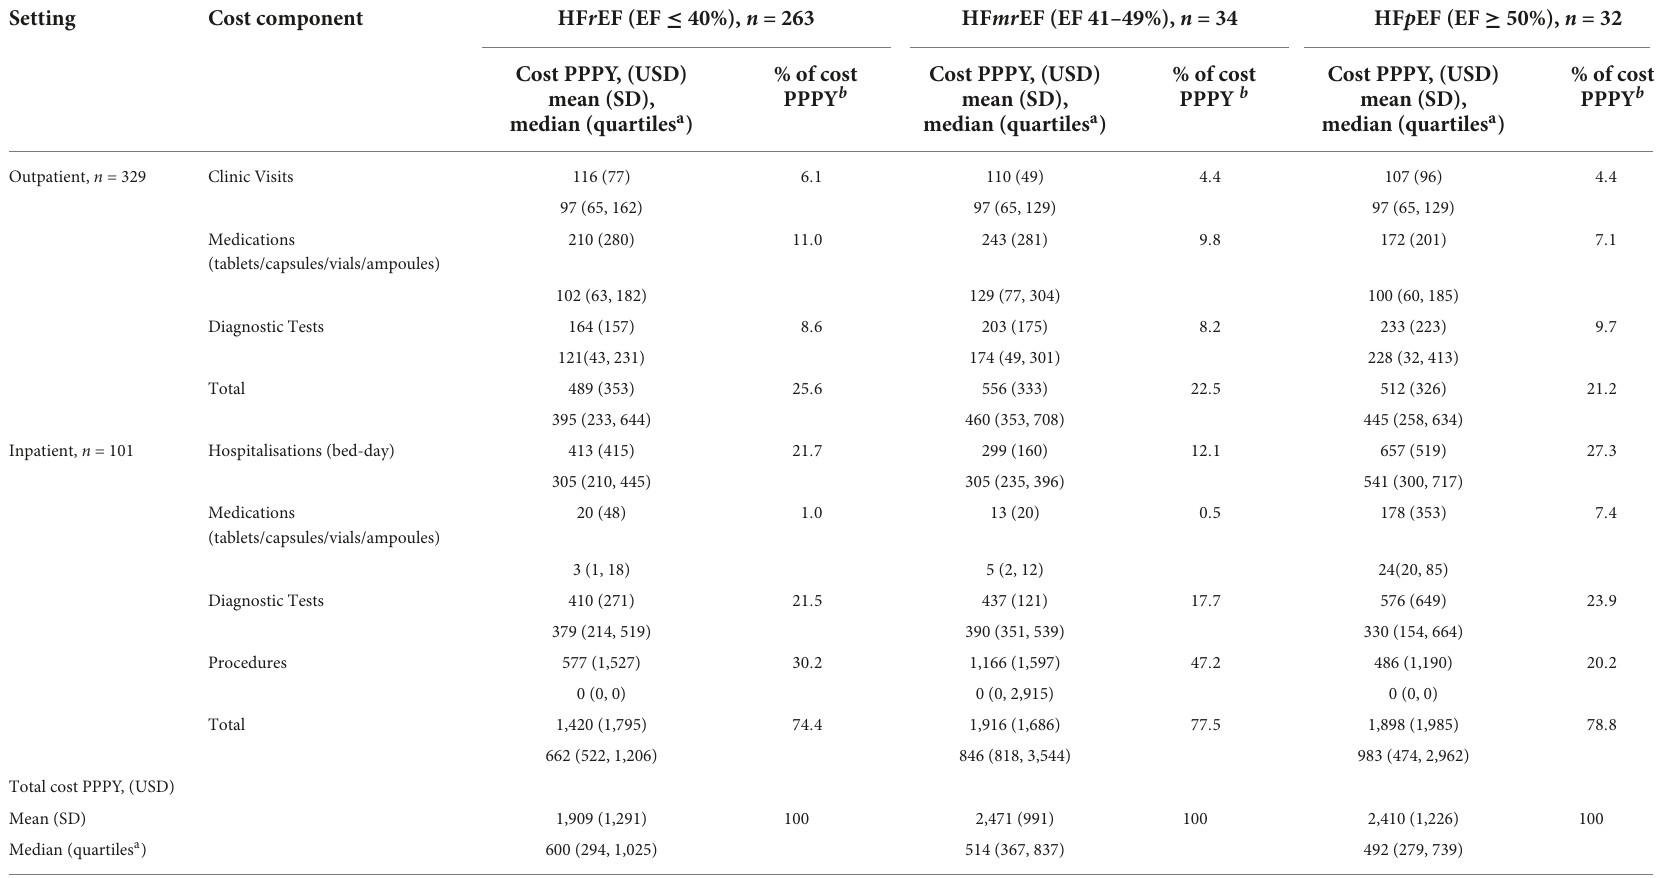
TABLE 3 Cost distribution of heart failure patients categorised based on left ventricular